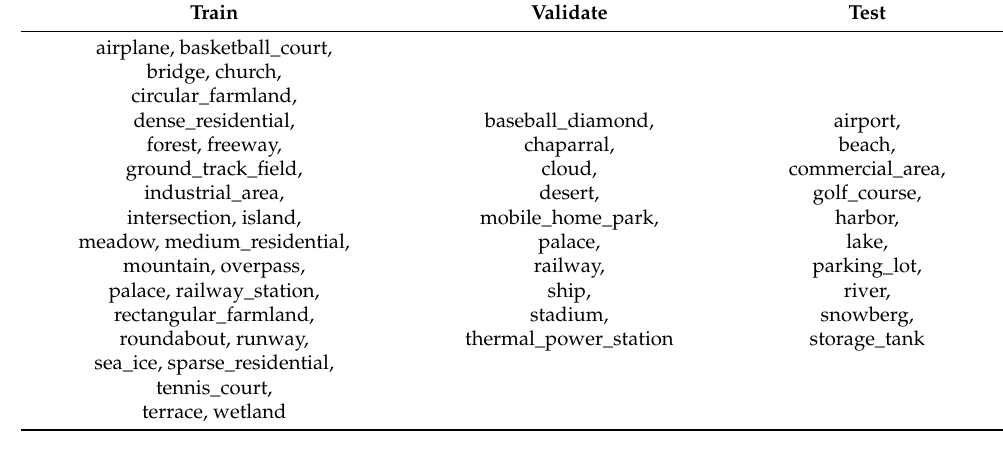
Table 2. Class segmentation for the NWPU-RESISC45 dataset.